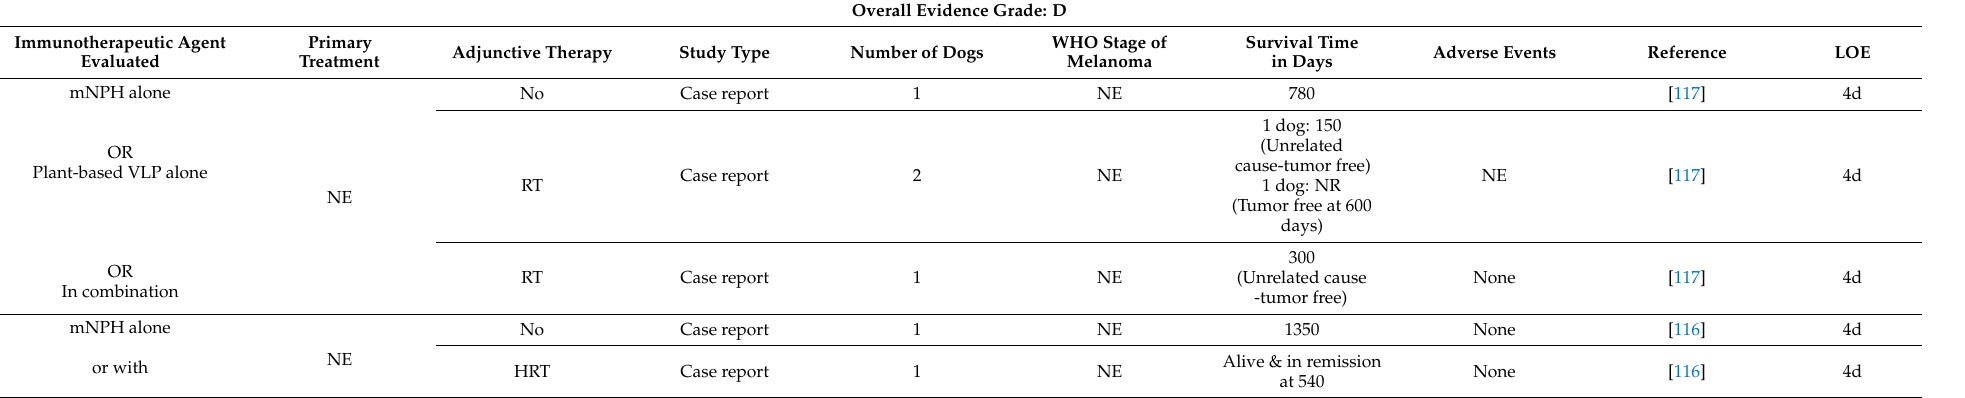
Table 17. Summary of nanotechnology studies evaluating effectivity in oral malignant